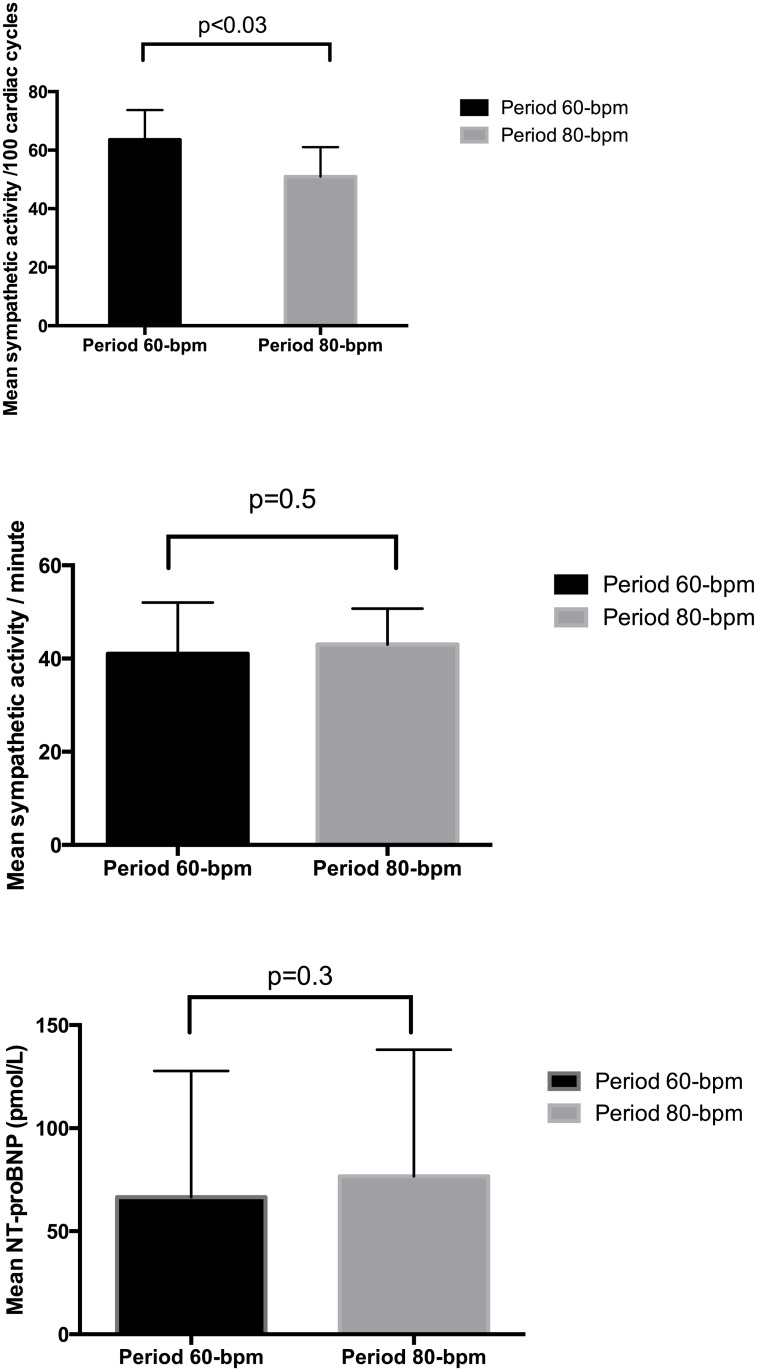
Top panel: Sympathetic activity in the 60-bpm vs. 80-bpm period.Bursts/100 RR: sympathetic bursts per 100 cardiac cycles. Lower panel: Mean NT-proBNP (pmol/L) in the 60-bpm vs. 80-bpm period.